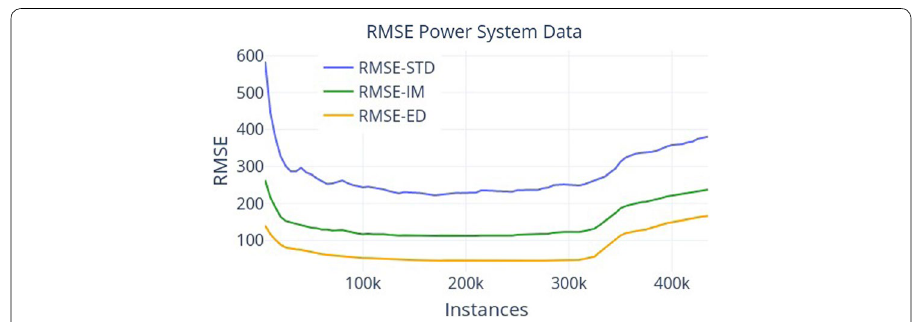
Fig. 5 RMSE comparison for the power system data